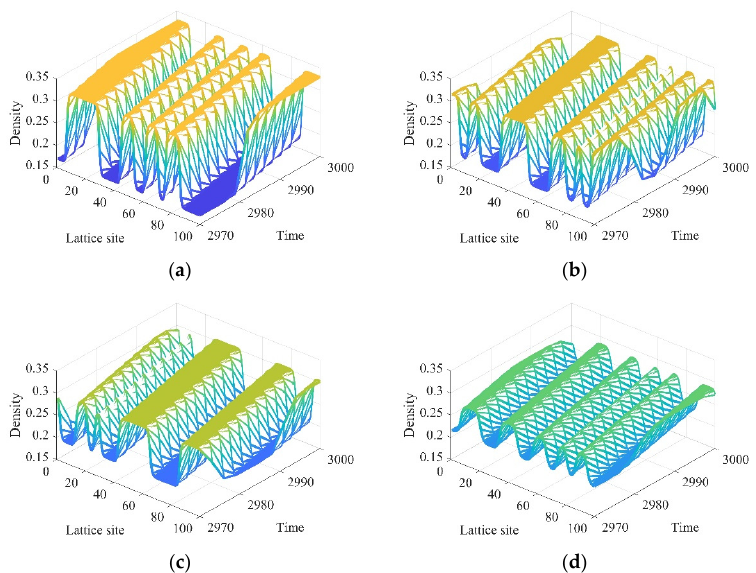
Figure 2. The evolution of the traffic densities for different values of parameter ξ . ( a ) ξ = 0, ( b ) ξ = 0.1, ( c ) ξ = 0.2, ( d ) ξ =